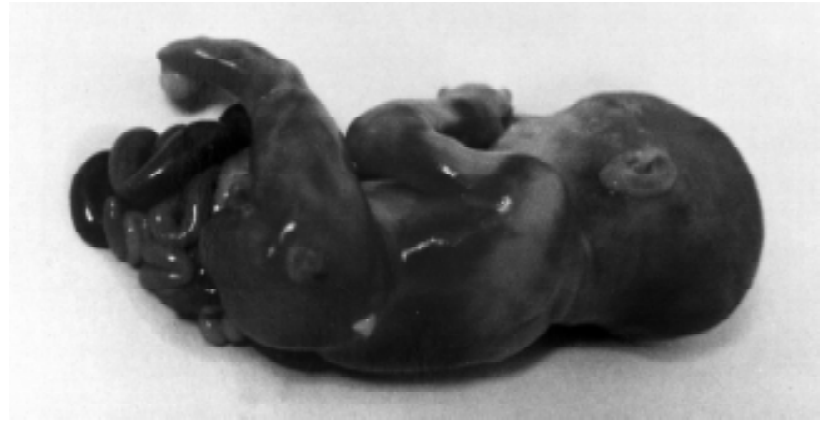
Figure 1 - Gastroschisis, sacral meningomyelocele and left clubfoot in the affected